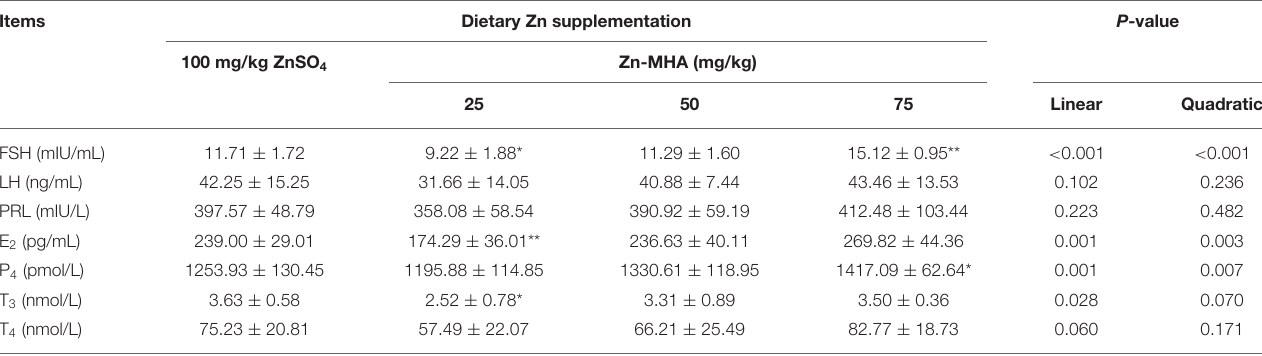
TABLE 6 | Effects of dietary Zn-MHA supplementation on serum hormone analysis of broiler breeders a .